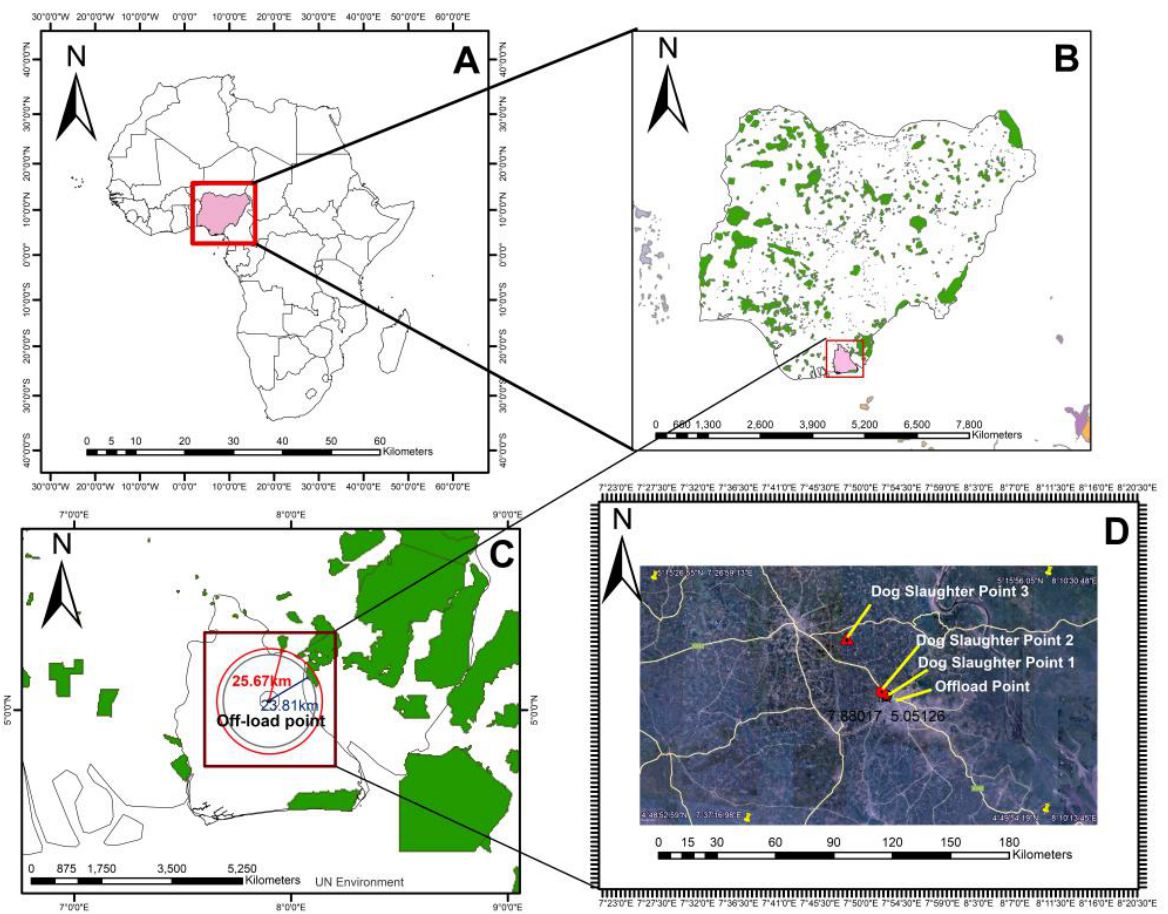
Figure 1. Map of the study area within the African continent ( A ), the country of Nigeria ( B ), and the Akwa Ibom state boundaries in Nigeria, ( C ) and the geographic distribution of dog slaughter slabs in Uyo, the capital city of Akwa Ibom state ( D ).